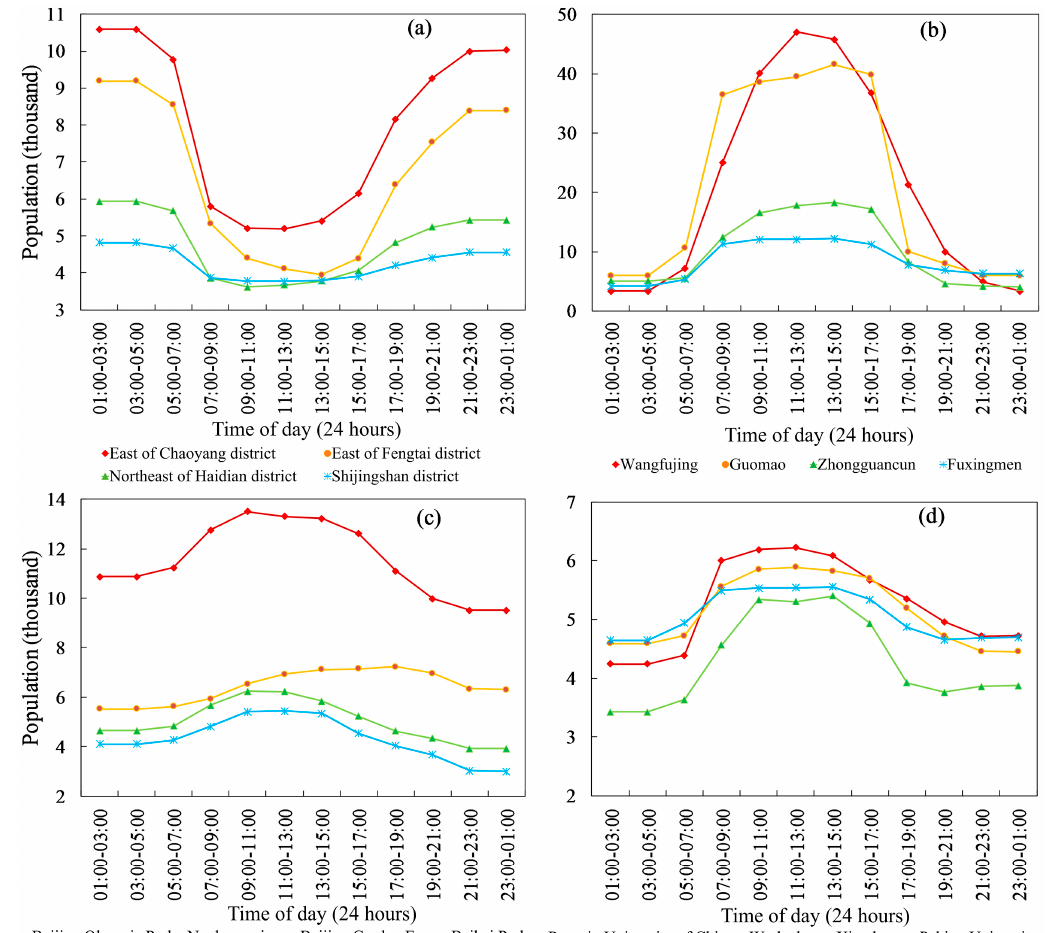
Figure 5. Population variations of typical communities. The average population of all communities within the catchment area of the corresponding subway station was used to derive the population variation of ( a ) residential communities; ( b ) commercial communities; ( c ) communities in the tourist areas; and ( d ) the university communities.